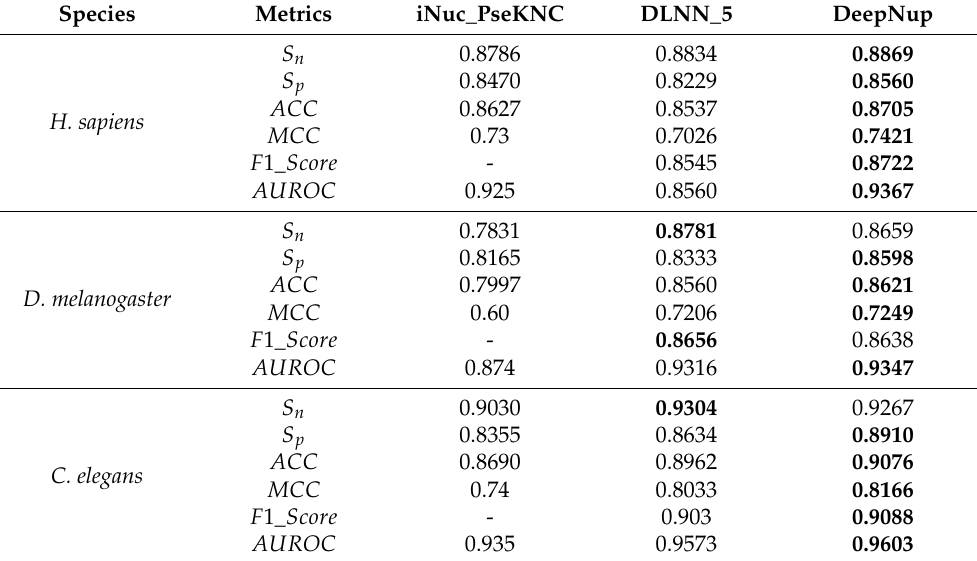
Table 5. Comparison of DeepNup with iNuc_PseKNC and DLNN_5 via 10-fold cross validation in 3